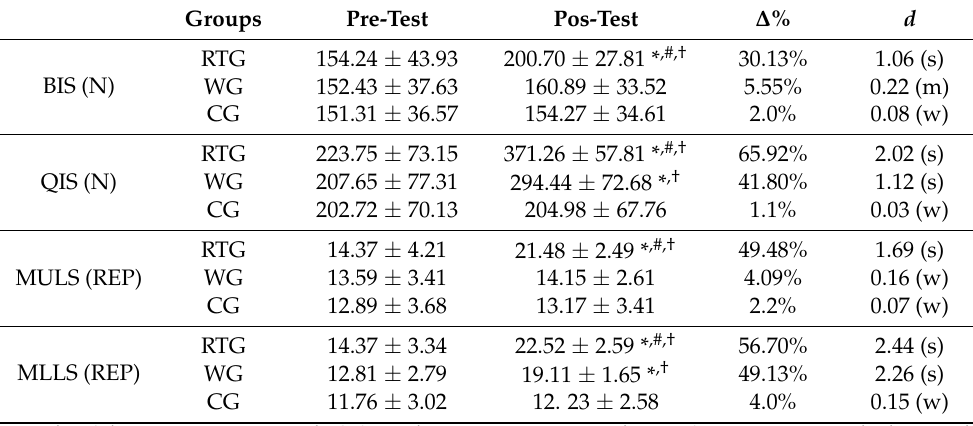
Table 2. Comparative analysis of isometric and dynamic muscle strength tests between the study